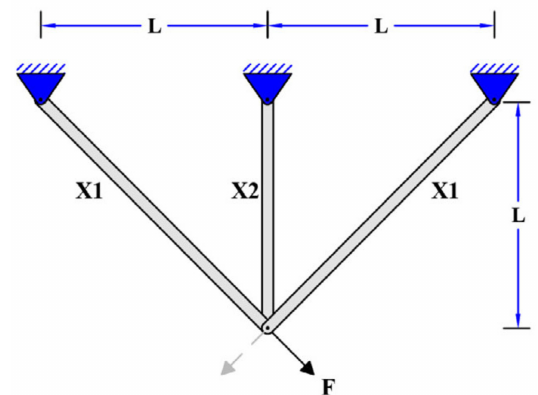
Figure 14. Three-bar truss